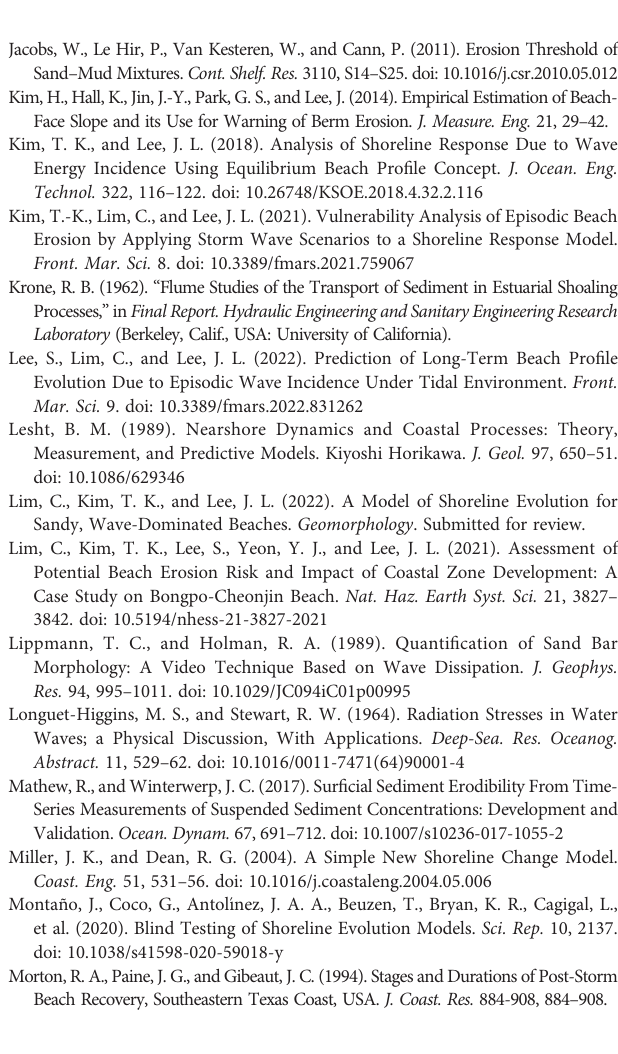
Supplementary Figure 1 | Estimation of beach response factor a r using correlation curve between equilibrium shoreline position and breaking wave energy. Supplementary Figure 2 | Validity of extreme analysis methodology applying shoreline evolution data at Tairua Beach, New Zealand. Supplementary Figure 3 | Category of shoreline shape: (a) straight type; (b) bow type; (c) basket type; (d) beak type; (e) pocket type (Google Earth and Kakao Map Image). Supplementary Figure 4 | Temporal series of NOAA wave data at breaking point: (A) wave height; (B) wave energy. Supplementary Figure 5 | Temporal series of tide